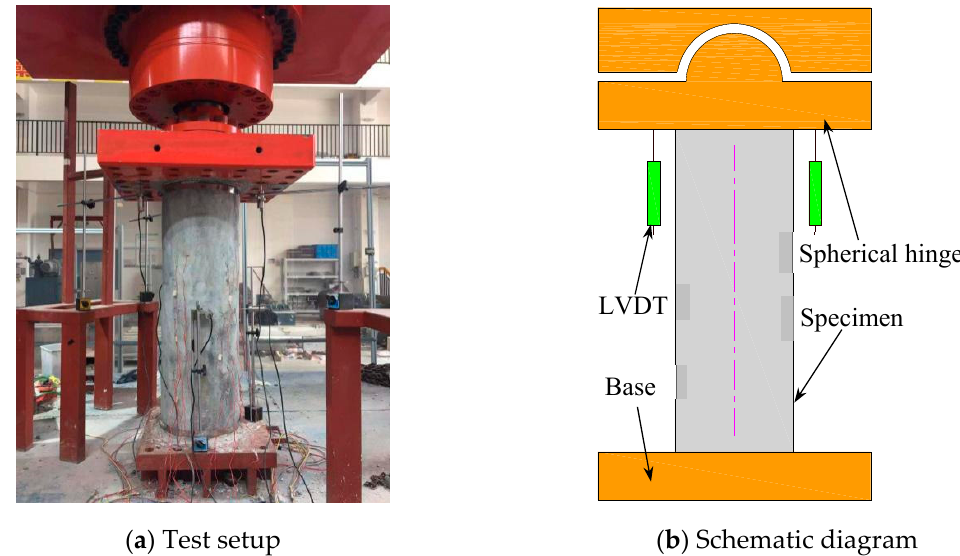
Figure 6. Test setup and schematic diagram of the axial compression test.